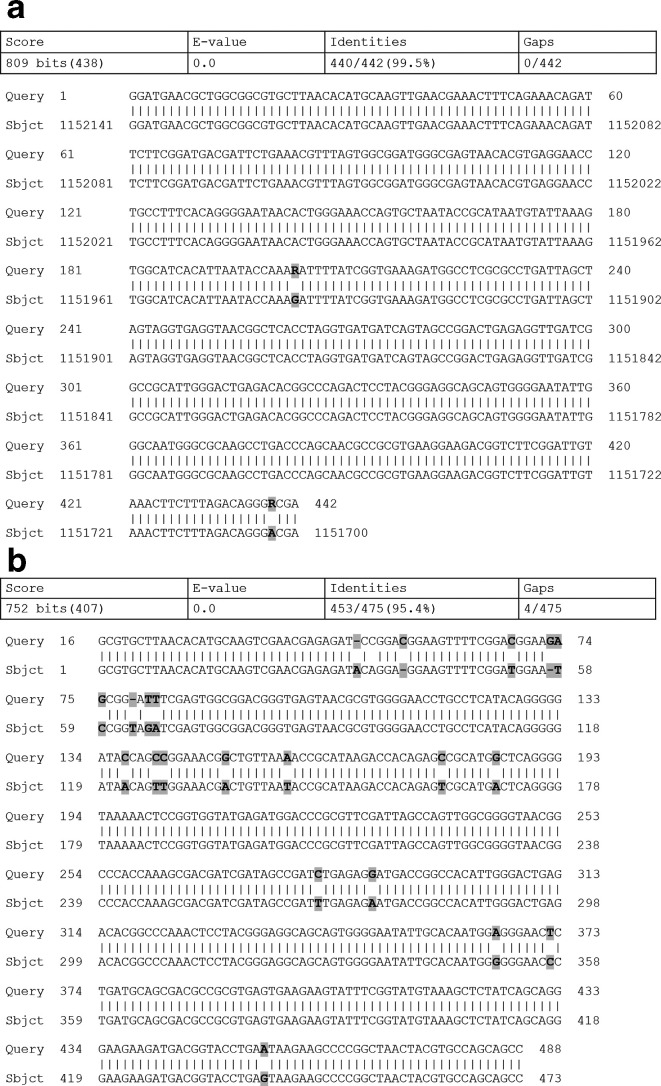
(a) Alignment of the partial 16S rRNA gene sequence from the case isolate of 
F. sanguinis
 with 
F. sanguinis
 strain CCUG 47711 chromosome, complete genome (sequence ID: CP027226). There are two mismatches at position 202 (G to R=A or G) and at position 439 (A to R) resulting in a match of 99.5 %. (b) Alignment of the sequence obtained from the mixed sequence from the case isolate using the Pathogenomix Ripseq software and database, of 
M. indoligenes
 with 
M. indoligenes
 strain MDA2477 (sequence ID: AF527773). There are several mismatches and gaps, resulting in a match of 95.4 %.